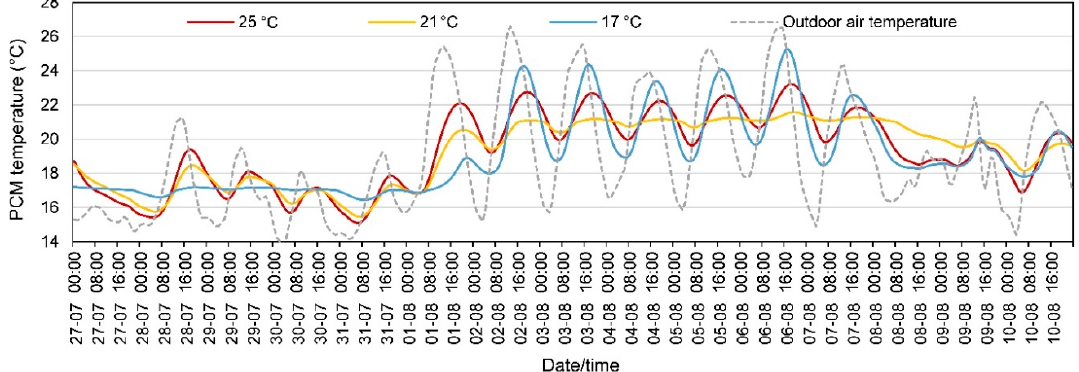
Figure 7. The PCM temperature profiles for models with different phase change temperatures for summer night cooling application.